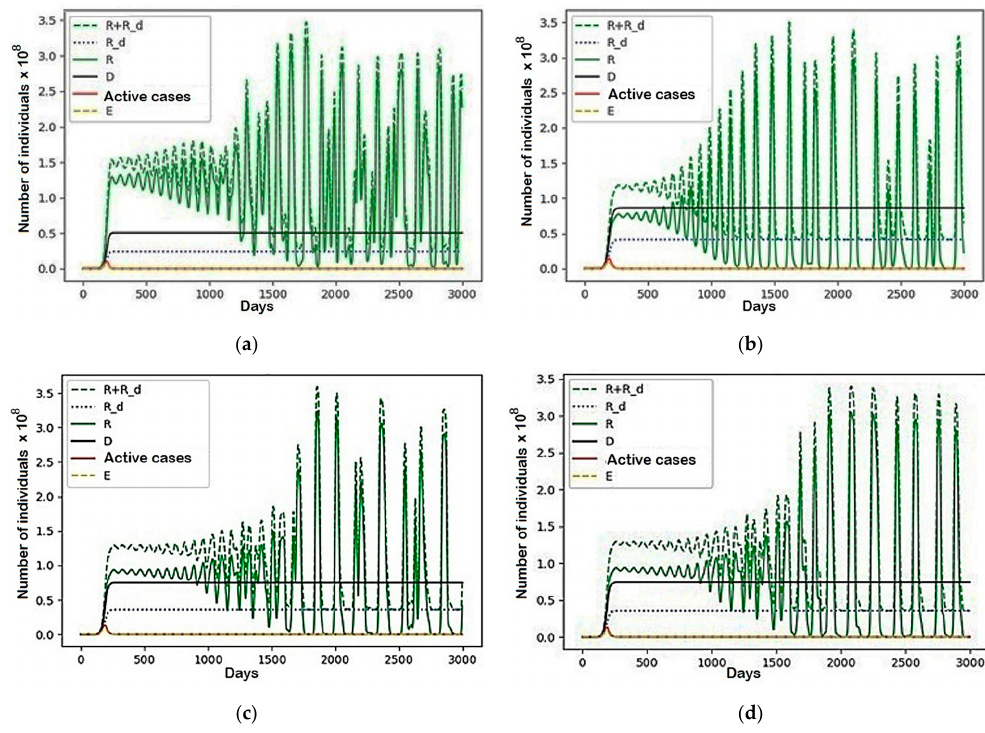
Figure 11. A scenario in which a 1 = 1, b 1 = − 0.1, b 4 = 0.05, c 1 = − 0.15, c 4 = 0.1, d 1 = − 0.3, d 2 = − 0.7, and the rest are equal to zero: ( a ) Region 1; ( b ) Region 2; ( c ) Region 3; ( d ) Region